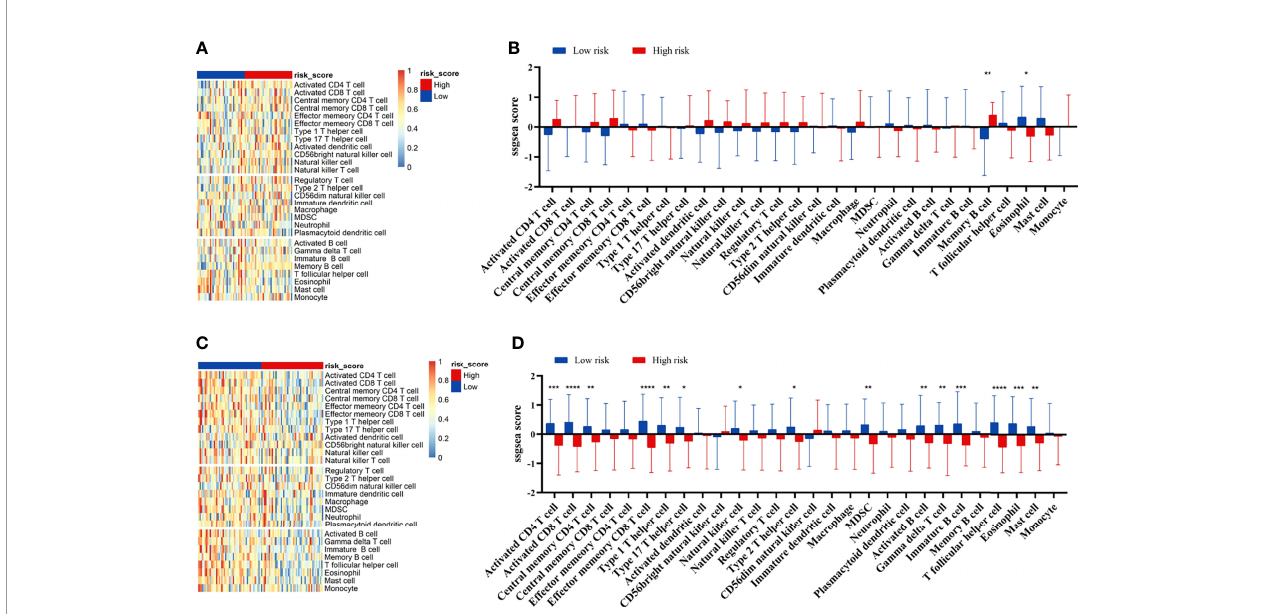
FIGURE 7 | Correlation between immune cell in fi ltration and the prognostic signature in the GEO cohort. The in fi ltration ratio of 28 immune cells in GEO42743 (A, B) and GEO41613 (C, D) . All p -values for signi fi cance (<0.05) represent comparisons via two-tailed multiple t -tests with FDR < 0.05. * p -value<0.05, ** p -value<0.01,